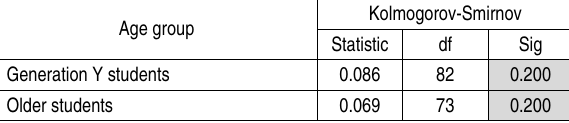
Table 5. Kolmogorov-Smirnov test for normality